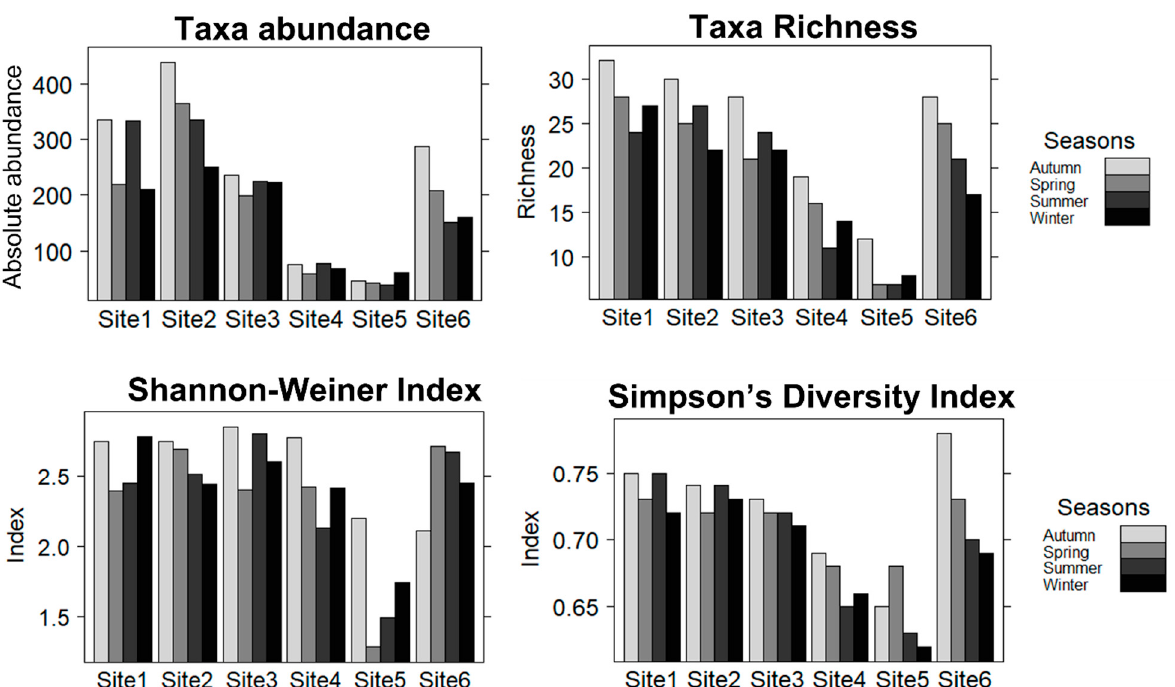
Figure 4. Taxa richness, abundance, Shannon-Weiner Index, and Simpson’s Diversity Index recorded along the longitudinal gradient of the Palmiet River in Durban.